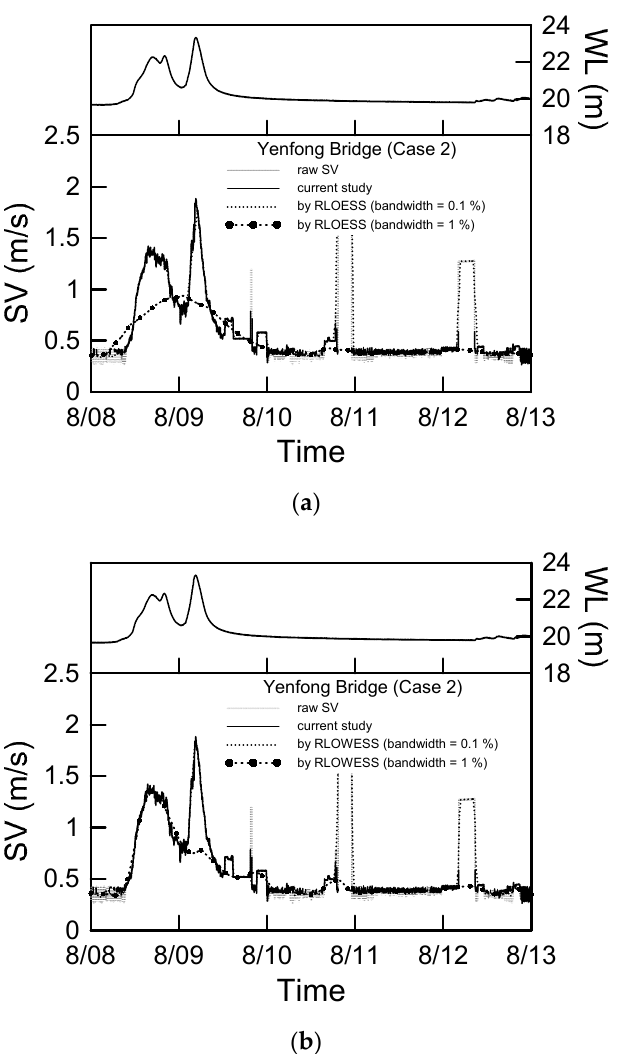
Figure 16. Local comparison of the filtered SV data with smoothing methods at Yenfong Bridge ( a ) smoothed by RLOESS; ( b ) smoothed by RLOWESS.